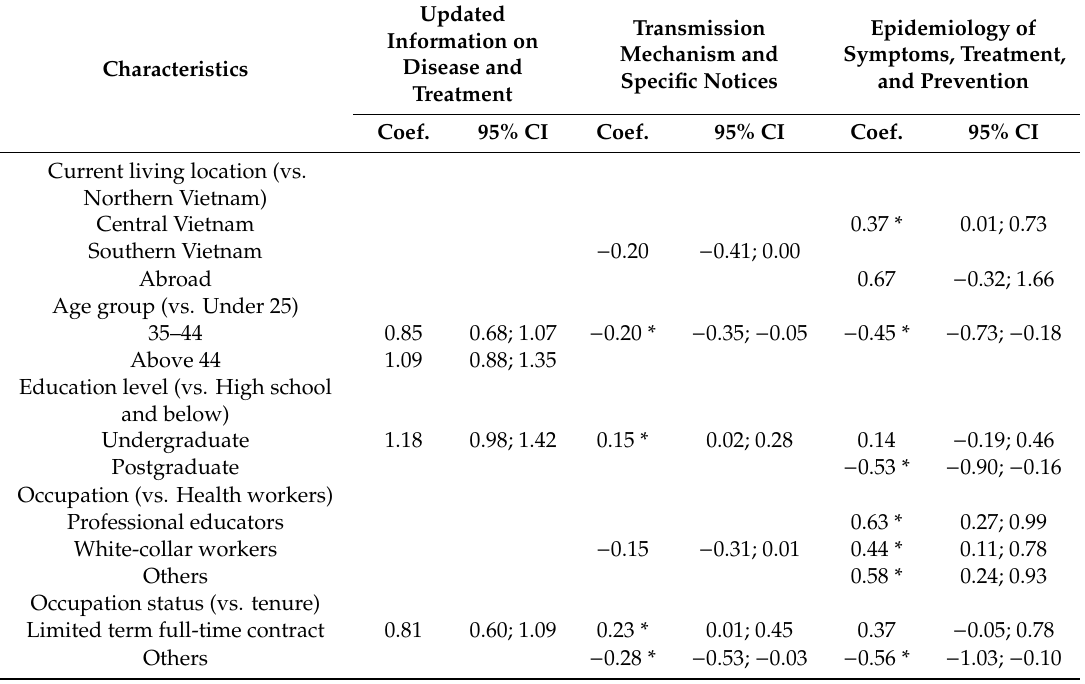
Table 3. Factors associated with demand for health information on COVID-19. Characteristics